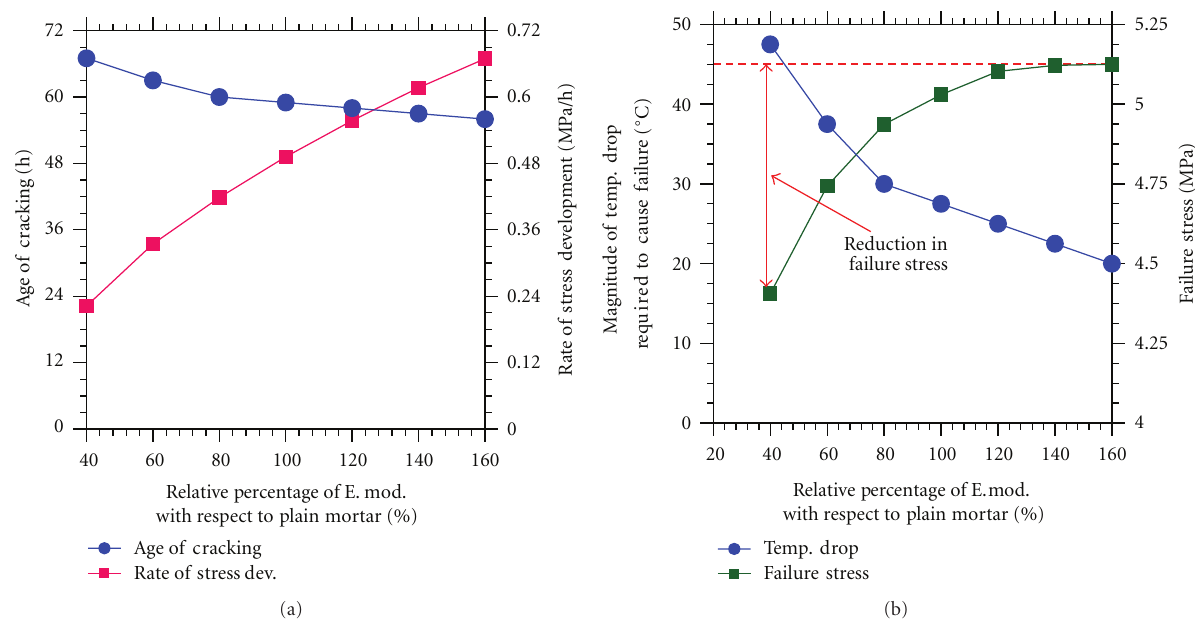
Figure 8: Influence of elastic modulus of the specimen on (a) the residual stress development, age of cracking, (b) the magnitude of temperature drop, and the reduction in strength.